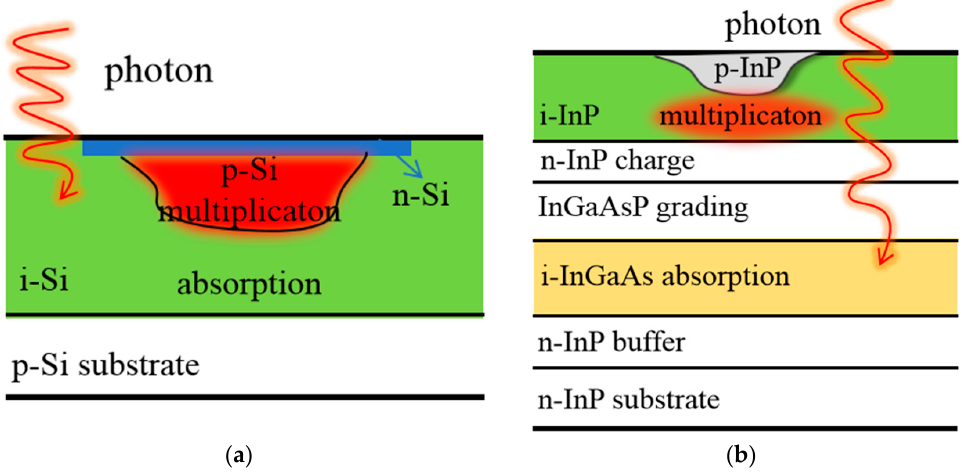
Figure 1. Schematic diagrams of a ( a ) Si-based APD and an ( b ) InP-based APD.